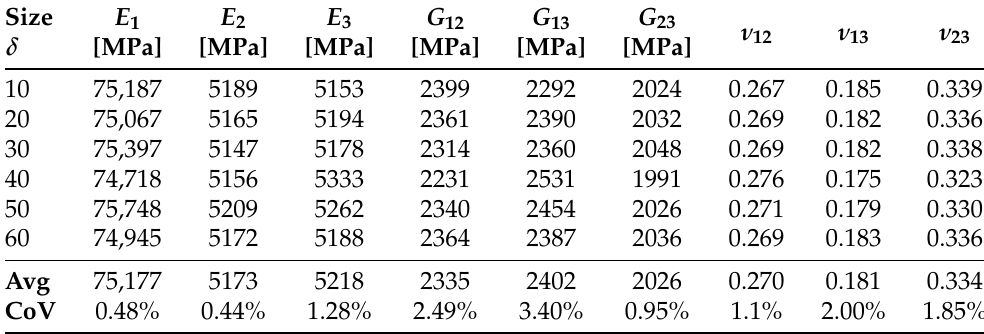
Table 7. Results obtained for the homogenized mechanical